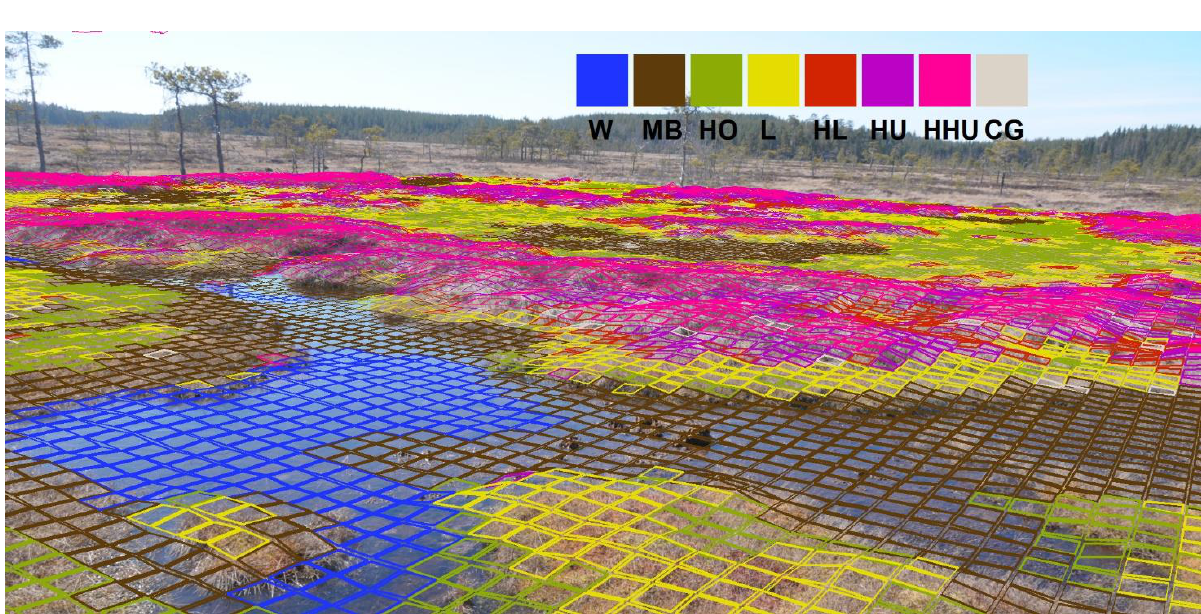
Figure 15. Class-by-class classification accuracy by using (a) the RF algorithm and RF variables and (b) the combined features in two feature sets and three classifiers.